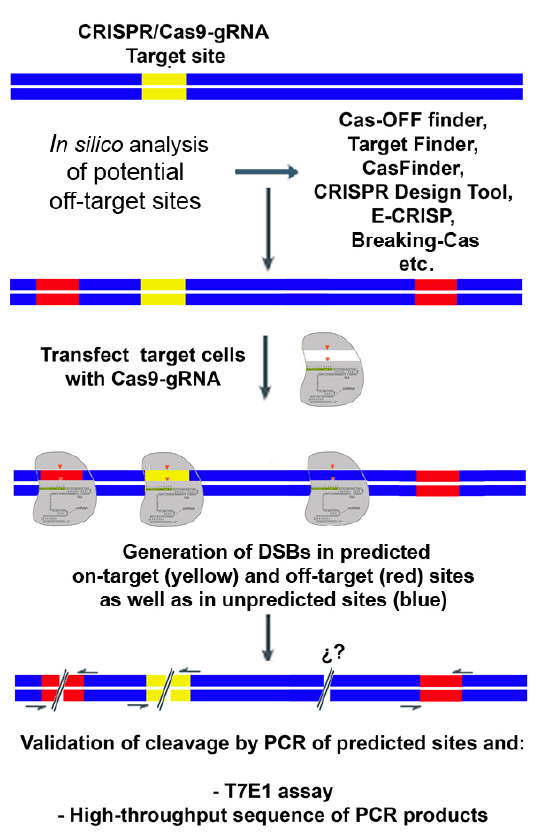
Figure 1. Biased off-target analysis using ChipSeq. Potential off-target sites (red) are predicted in silico by different programs freely available on the internet. The cells are transfected with the Cas9 and the gRNA, which generates DSBs at the in-target site (yellow) and in the off-target sites (red and blue). In-target and predicted off-target sites (red) can be analyzed by PCR and T7E1 assays or by high-throughput sequencing. However, the DSBs generated outside the predicted sites (blue) are undetectable by these methods.